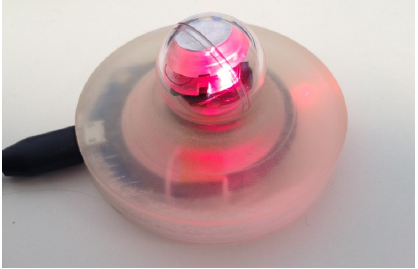
Figure 11. The capsule with integrated wireless recharging system charging on the dedicated docking